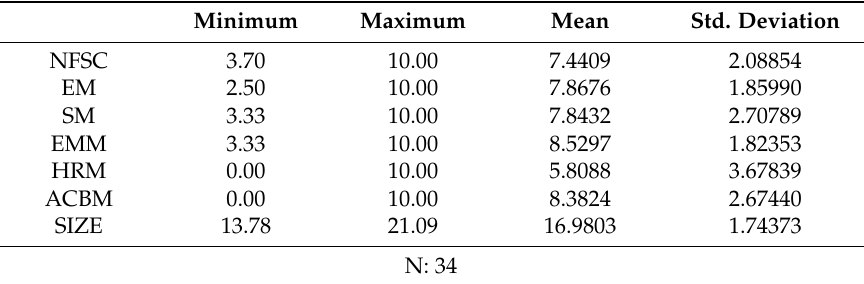
Table 4. Descriptive statistics—Continuous variables.